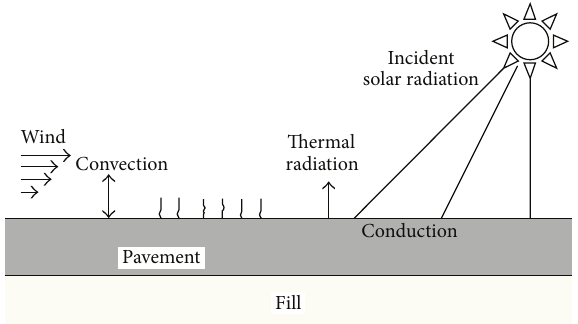
Figure 1: Various modes of heat transfer in asphalt